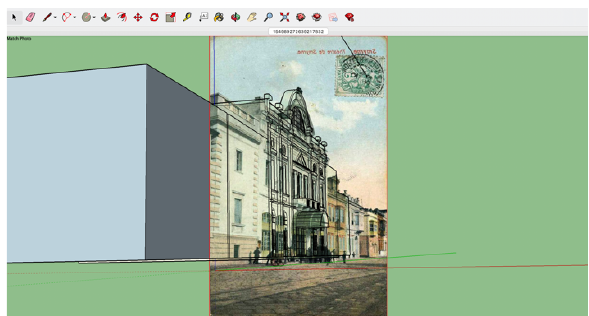
Figure 6. 3D render of Yilanli Mermer District further developed for VR experience- Thessaloniki